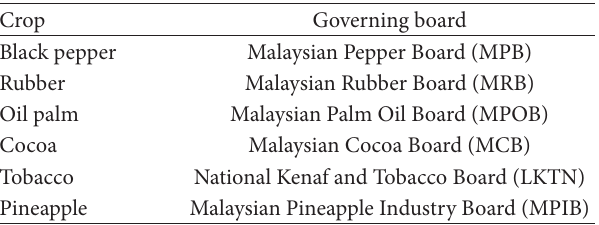
Table 3: Crops and governing board in Malaysia.